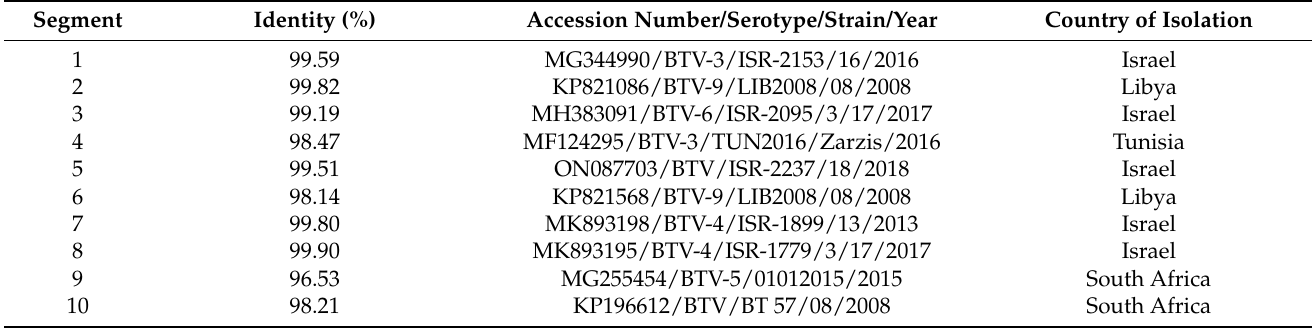
Table 5. BLAST analysis of Israeli BTV-9 ISR-1763/3/19 stain with global BTV